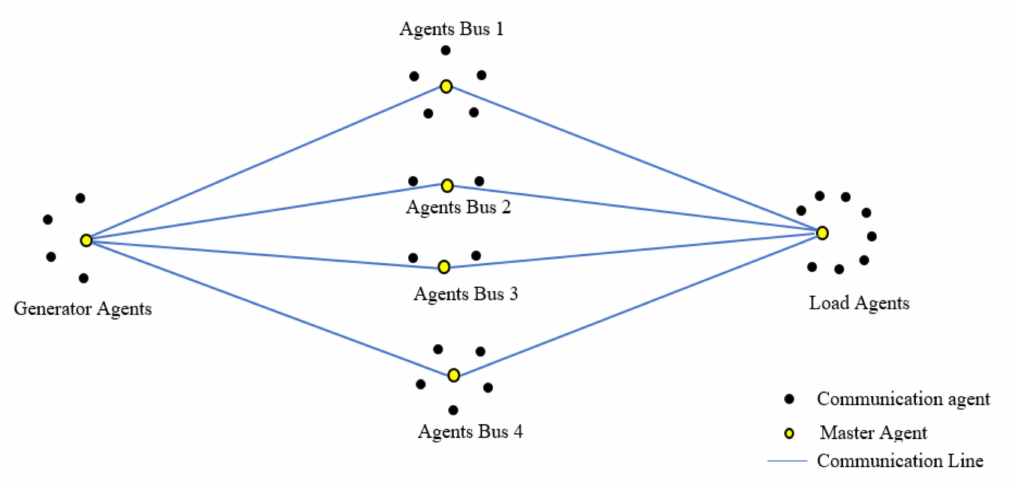
Figure 4. Construction of a microgrid bus system-based communication